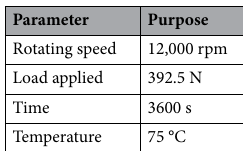
Table 4. Operating Parameters for four-ball